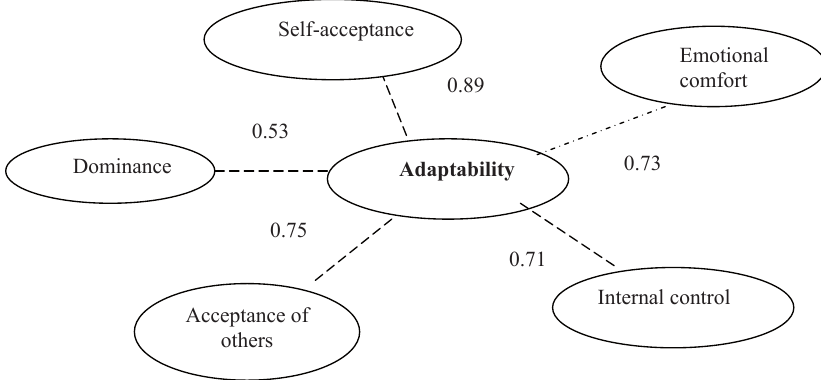
Fig.3 Correlational connections between the “adaptability” scale and the method scales of socio-psychological adaptability diagnostics by Rogers and Dymond in the LUTA listeners